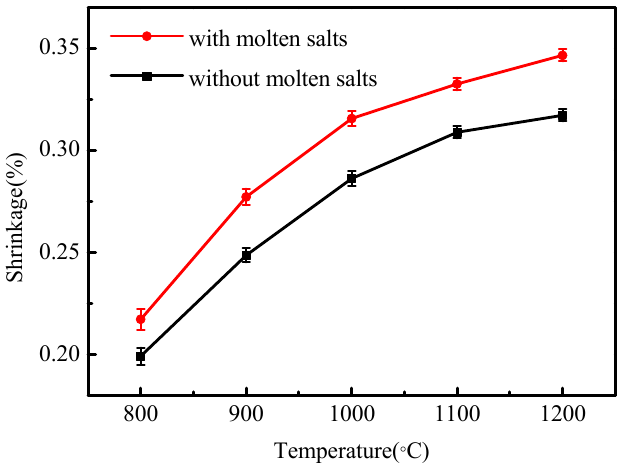
Figure 7. The shrinkage rate of KGP samples under different sintering conditions.